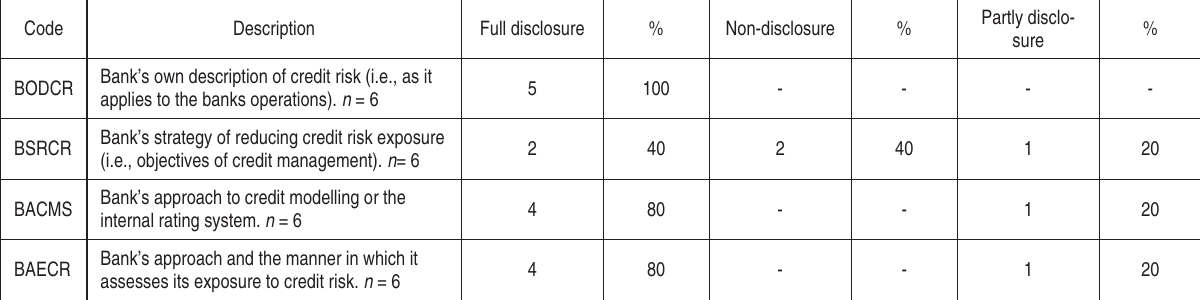
Table 2. Consolidated